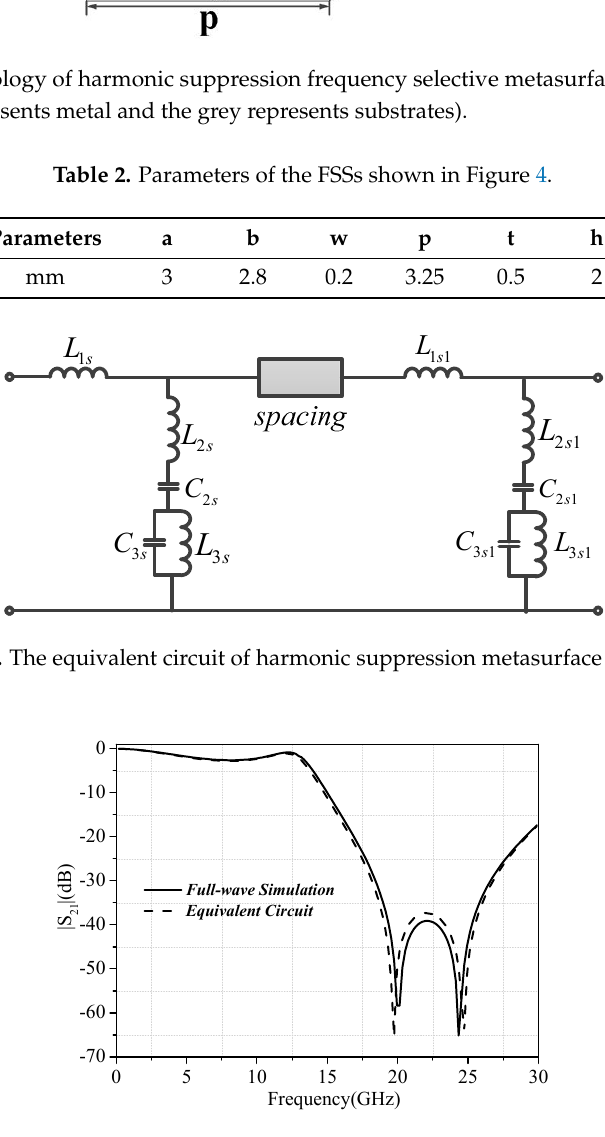
Figure 6. Comparison of transmission coefficients of the full-wave simulation and equivalent circuits of the harmonic suppression FSMSE.